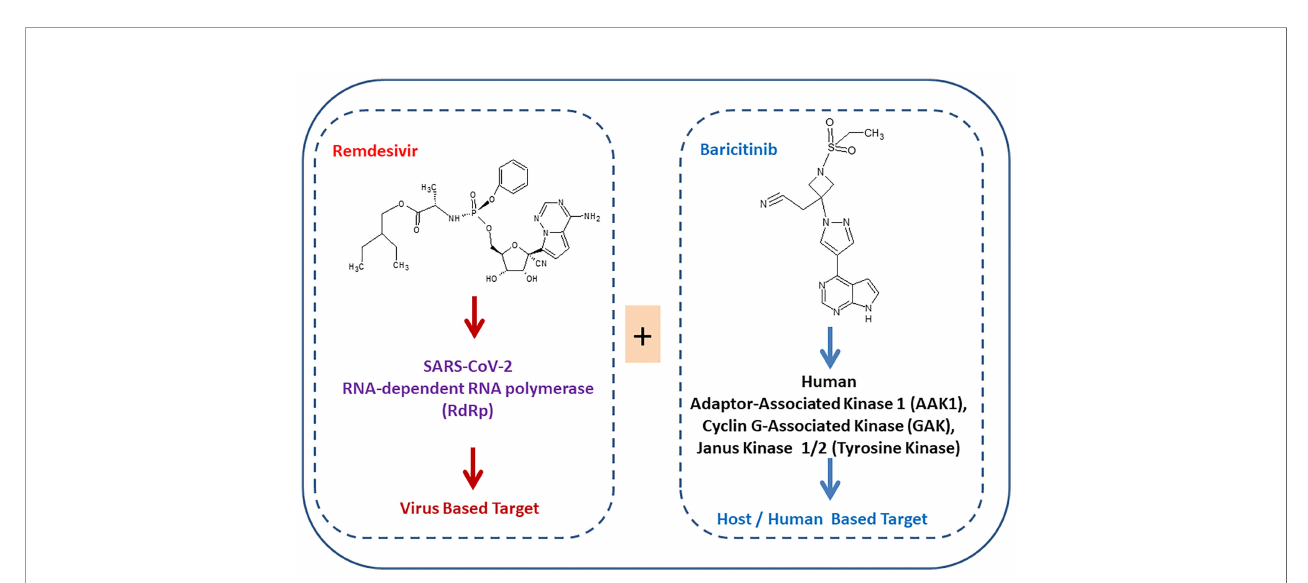
FIGURE 4 | Schematic representation of baricitinib as a repurposed drug for